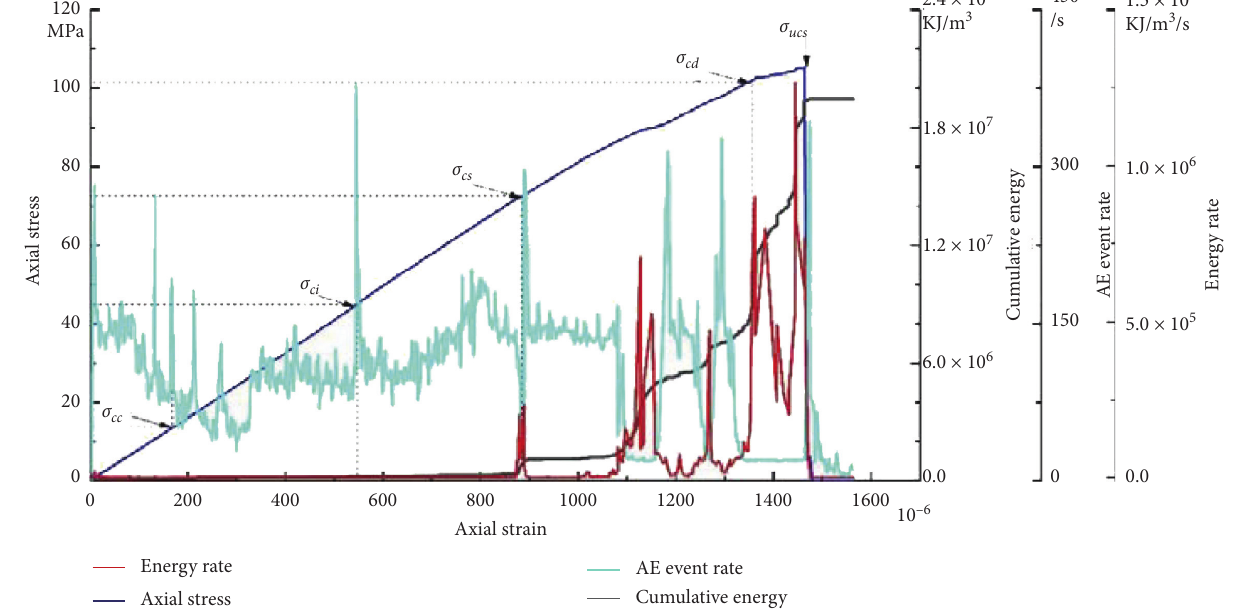
Figure 2: Stress, acoustic emission event rate, cumulative energy, and energy rate versus strain curves.